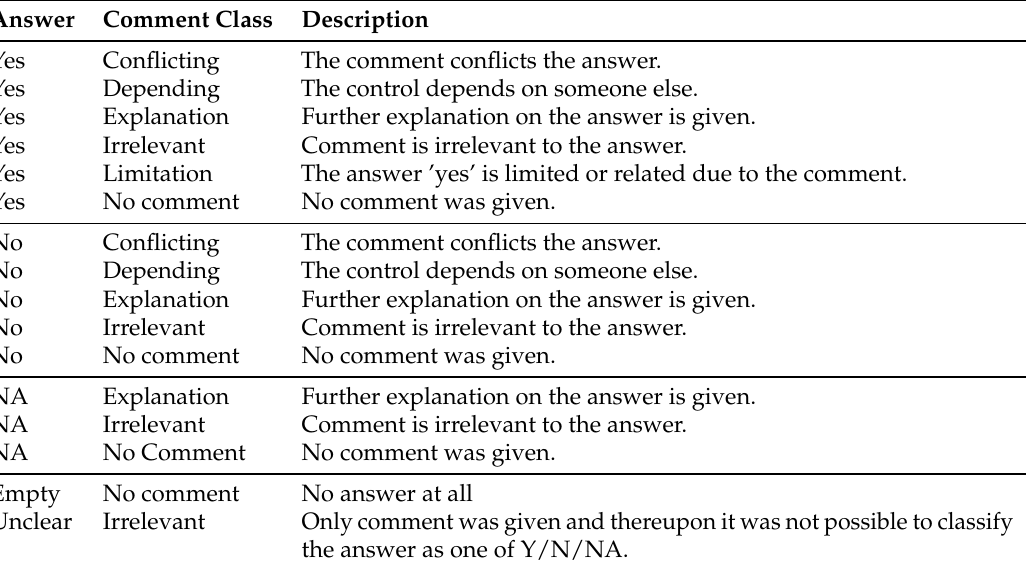
Table 6. Possible Classes for Answers in